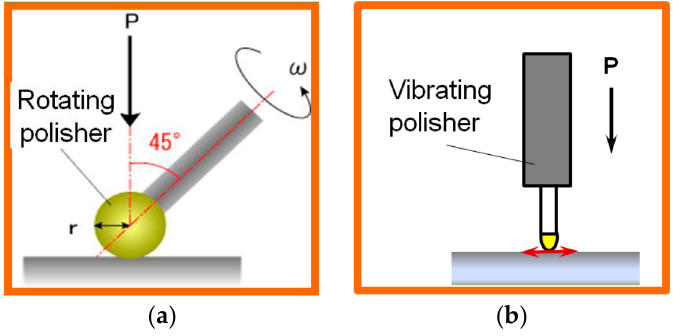
Figure 5. Mathematical models of polishing using ( a ) rotating and ( b ) vibrating tools.